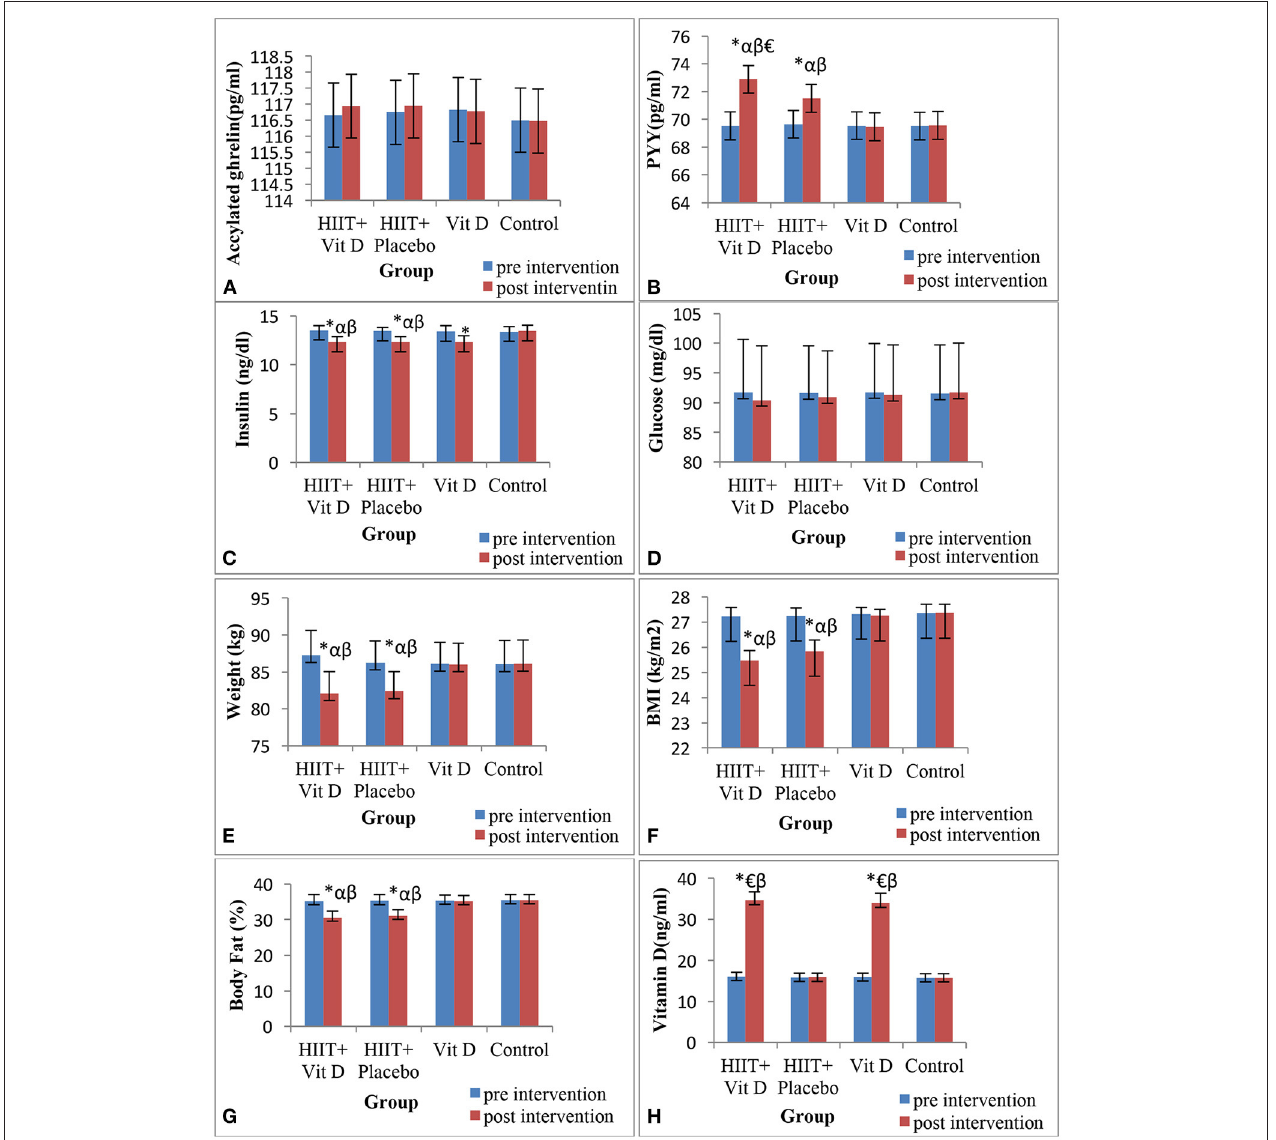
FIGURE 1 | Changes in acylated ghrelin (A) , peptide YY (PYY) (B) , insulin (C) , glucose (D) , body weight (E) , BMI (F) , body fat percentage (G) and vitamin D (H) during 8 weeks of HIIT protocol in overweight sedentary men. *Significant difference compared to the pre-test; α Significant difference compared to the Vitamin D group; β Significant difference compared to the control group; e Significant difference compared to the HIIT + Placebo group.